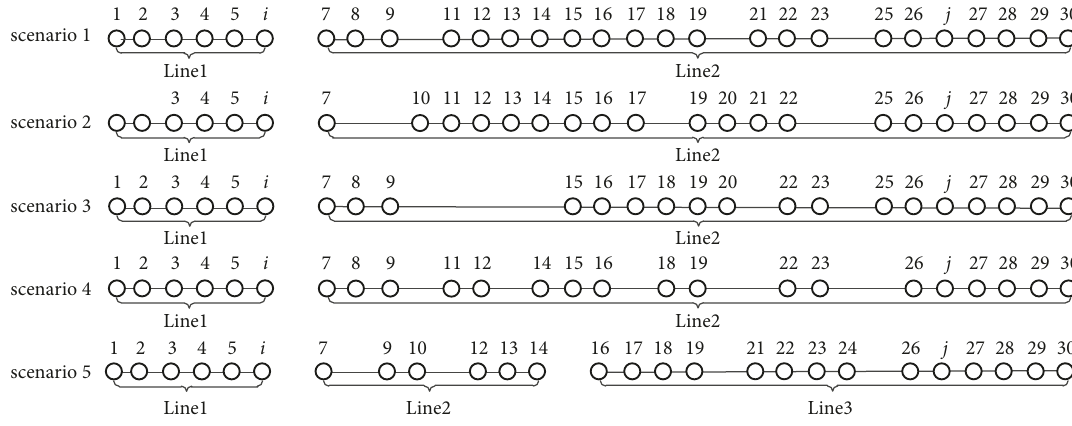
Figure 9: The optimal line forms of the bus line in different